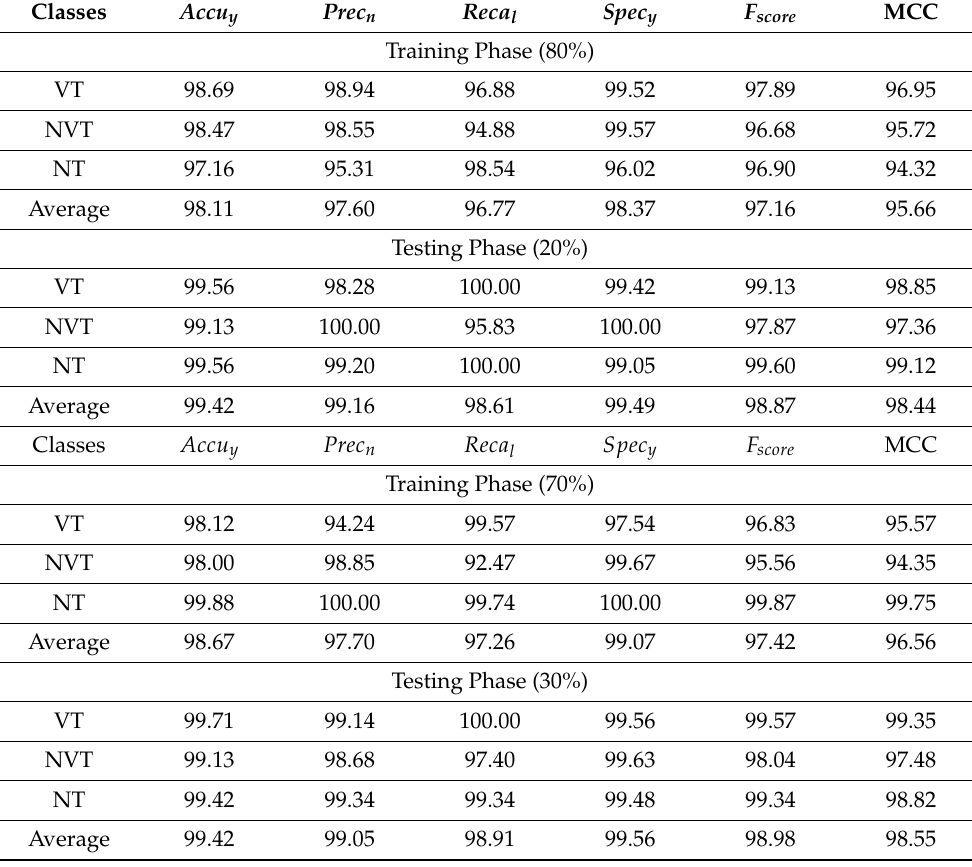
Table 3. Classifier outcome of AAOXAI-CD approach on